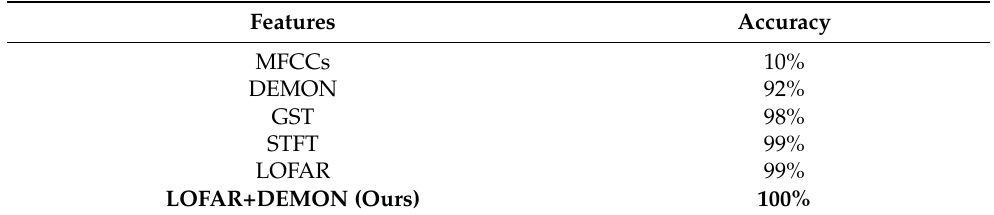
Table 4. Performance of each feature when feeding into the CRNN for F 0 estimation on the simulation dataset (COMB excluded).